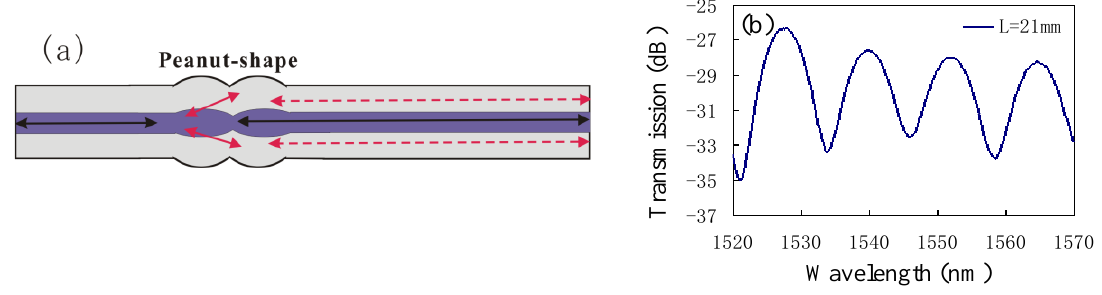
Figure 15. The peanut-shape based MI with L = 21 mm: ( a ) schematic; ( b ) reflection spectrum.